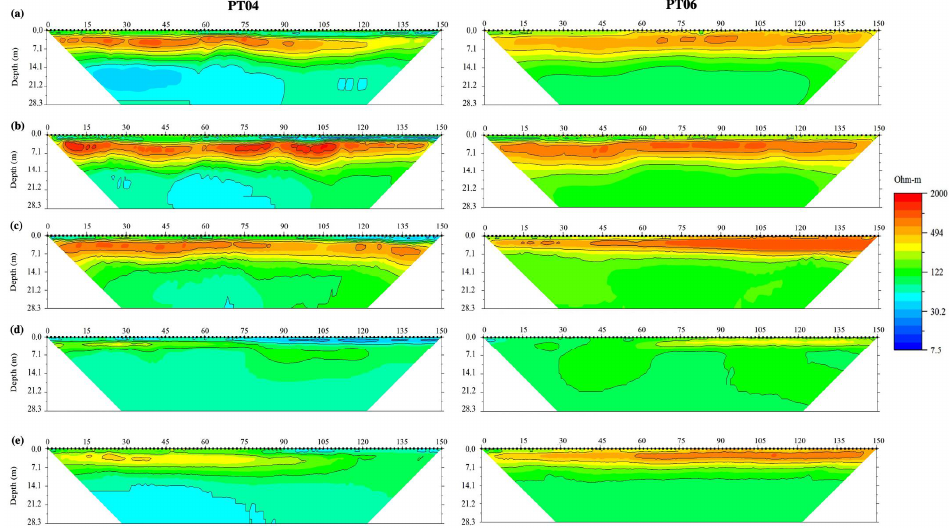
Figure 8. Time-lapse inverted resistivity models of PT04 and PT06 sites for ( a ) February, ( b ) April, ( c ) July, ( d ) September, and ( e ) November.